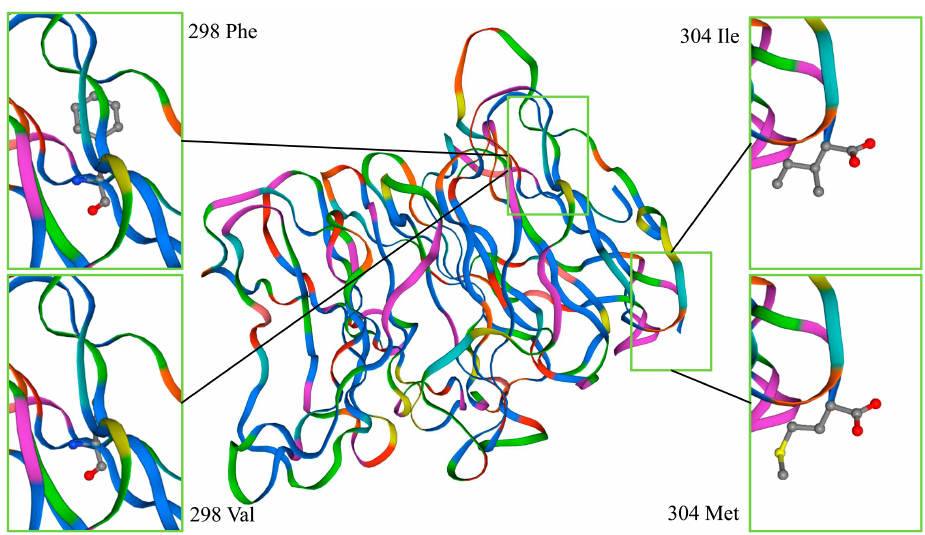
Figure 4. SNP3 and SNP4 affect the NUP37 protein. The structure of the NUP37 protein was unchanged due to SNP3 and SNP4. The 304th amino acid of SNP3 in the upper right corner is Ile, and in the lower right corner is Met. The 298th amino acid of SNP4 in the upper left corner is Phe, and in the lower left corner is Val.